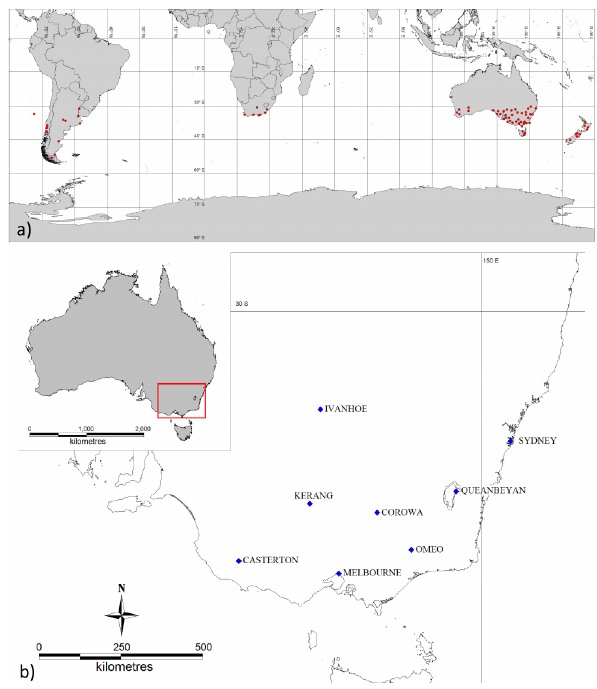
Figure 1. Location of (a) monthly rainfall stations (red circles) and (b) eight high-quality daily rainfall stations in SEA (blue dia- monds). Note monthly station data varies in length with all stations containing data from at least 1920 to 2009 (with the exception of two stations from Argentina that include data from 1931 onwards, which were included in order to improve the spatial coverage of the east coast of South